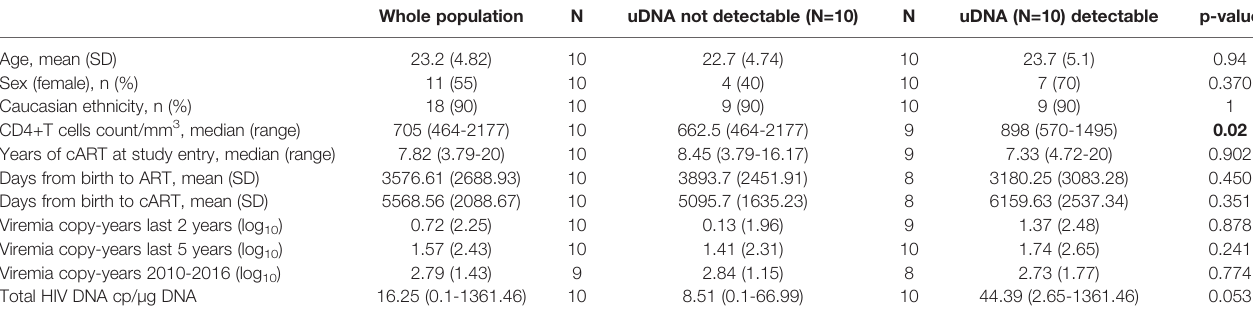
TABLE 1 | Comparison of clinical and demographic and virological features of the study population, according to unintegrated DNA (uDNA) value, detectable vs. target not detected. Whole population N uDNA not detectable